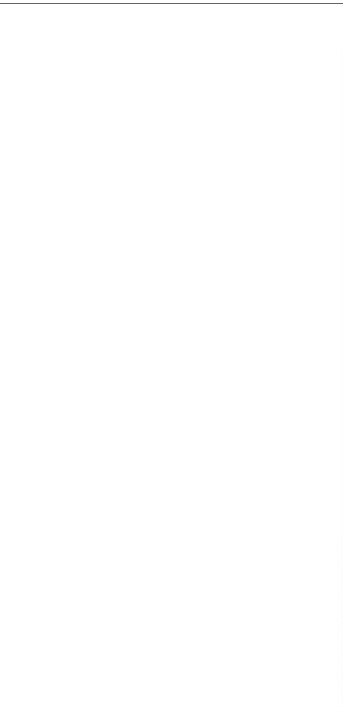
FIGURE 4B | (A – I) Images in 42-year-old man with hepatocellular carcinoma in the right hepatic lobe (arrow) and hilar lymph node metastasis. The hepatic lesion showed high uptake (TLR=7.66). The baseline AFP was >60500 and the Child-Pugh score was 6. The patient underwent right hemihepatectomy after 4 cycles of combination of pembrolizumab plus lenvatinib therapy. Histopathologic evaluation of response revealed good response to therapy (complete disappearance of the tumor cells, J – L